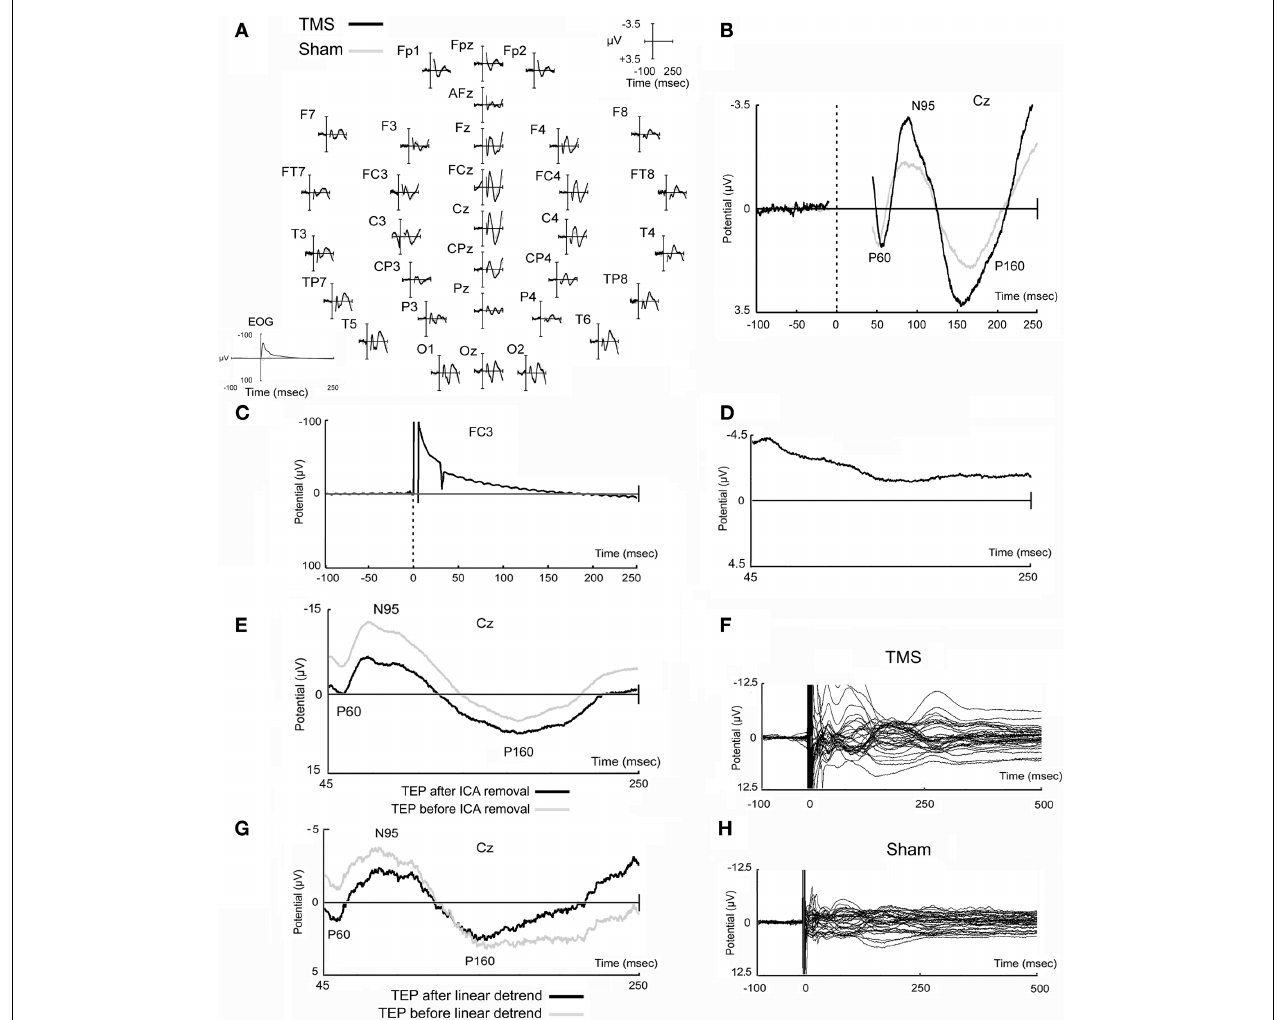
FIGURE 2 | Real and sham TMS-evoked potentials. Evoked potentials obtained in real and sham TMS conditions as recorded in all electrodes (A) and in the representative Cz electrode (B) . In EOG data, TMS artifact is fully reported and appears longer likely due to filtering settings (A) . Potential that has been obtained in a prototypical electrode after the stimulation of the watermelon is also shown (C) , as well as a prototypical independent component, evidently related to TMS artifacts, that has been removed from